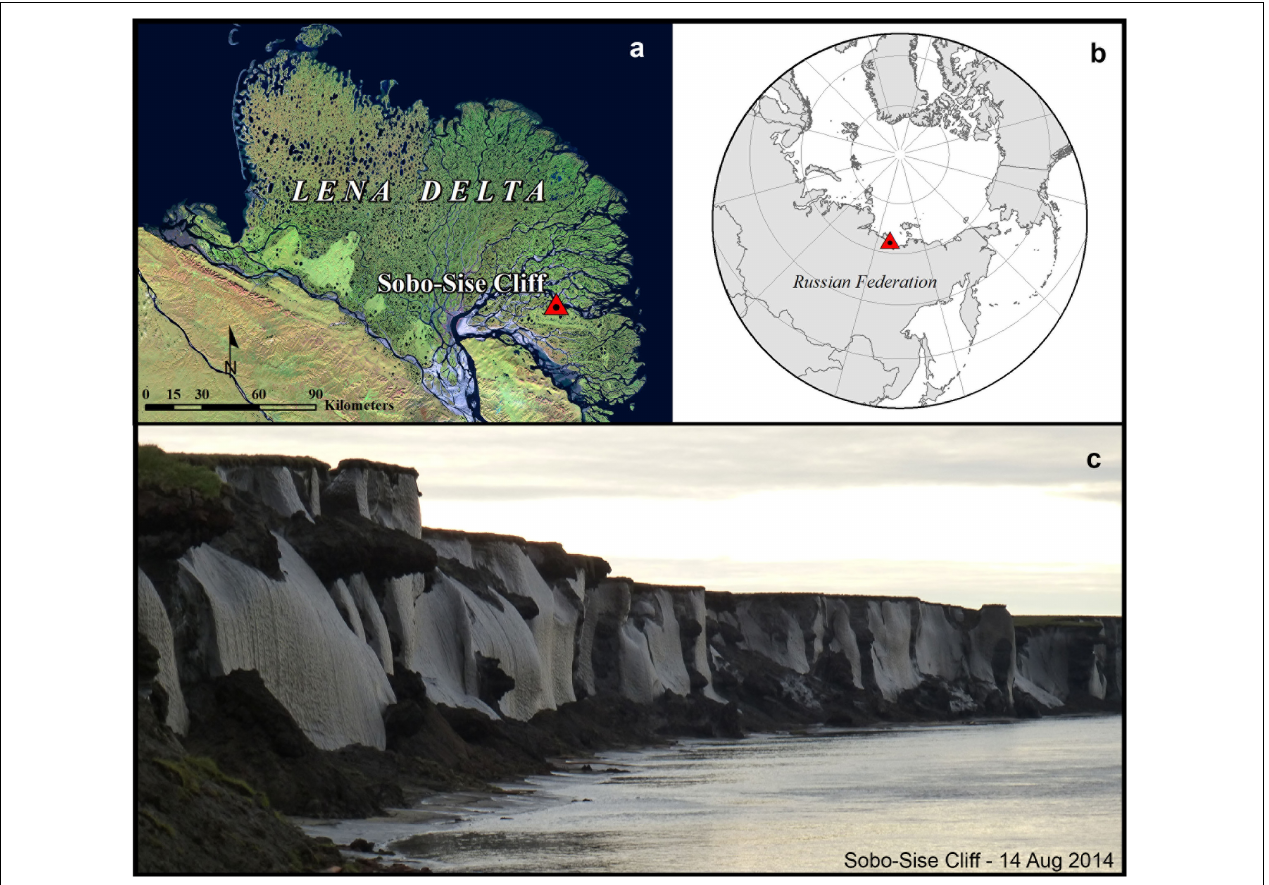
FIGURE 1 | Overview of the study site. The red triangle shows the location of Sobo-Sise Cliff in the eastern Lena River Delta (a) in the north of East Siberia, Russia (b) . [Lena Delta map is a mosaic compiled of six Landsat 5 scenes (bands 6-5-4) from 2009 to 2010.] Panel (c) shows the very ice-rich and up to 27.7 m high Sobo-Sise Cliff in August 2014 (photo: I.